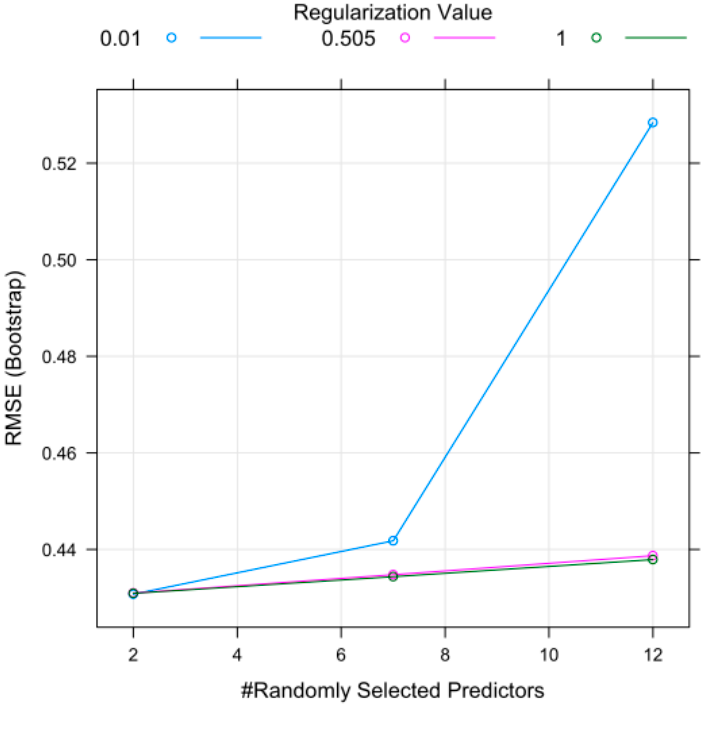
Figure 5. Evaluation parameters in RRF mode.